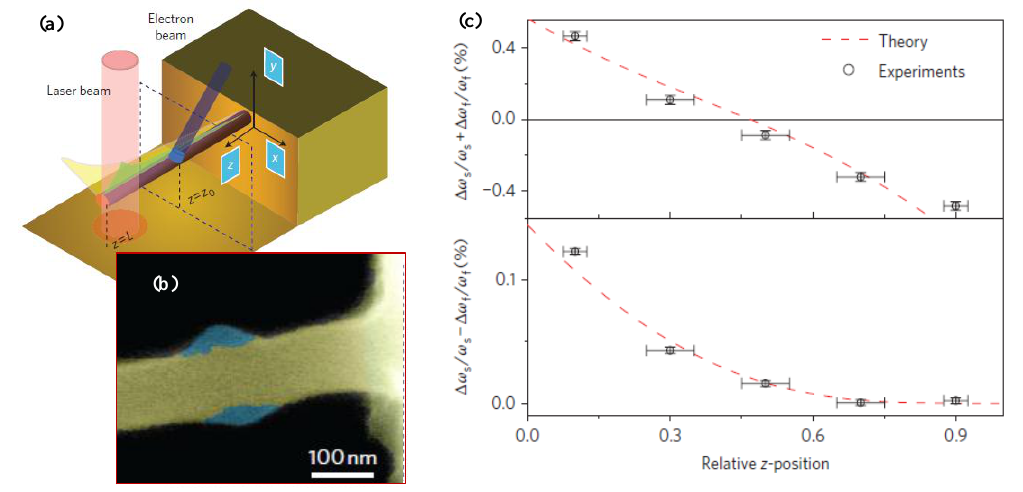
Figure 6. Effect of mass deposition position on the frequency shift in a nanowire resonator reported by Gil-Santos et al . [93]. ( a ) Schematic of electron-beam-induced deposition of carbon on nanowires; ( b ) SEM image of the nanowire after electron-beam-induced carbon